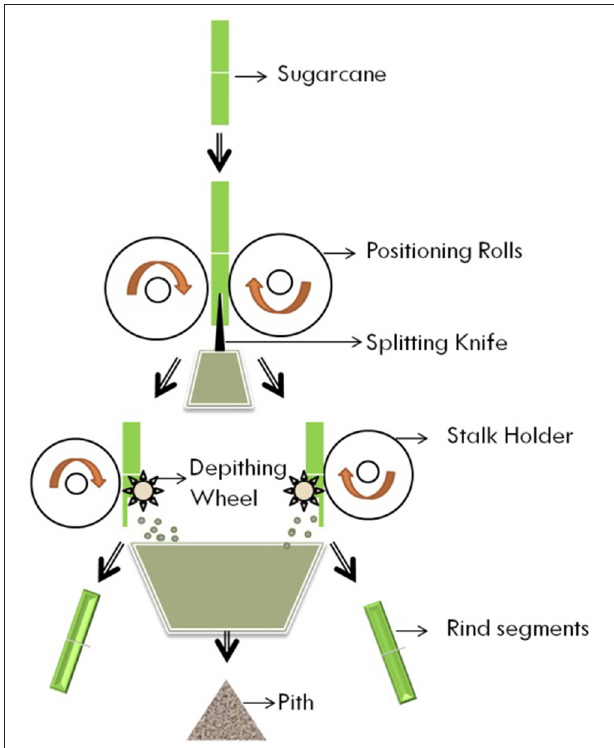
FIGURE 4 | Pictorial of Tilby process of sugarcane extraction.